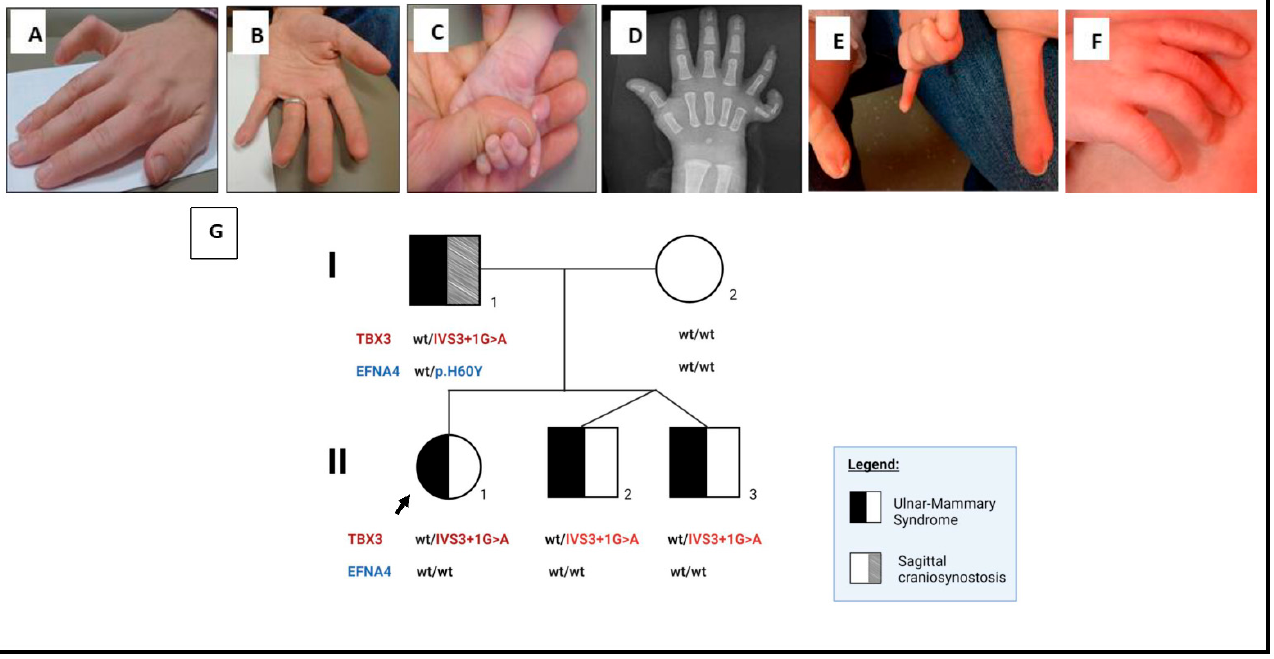
Figure 1. Phenotypic and genotypic findings in the proband and her family. ( A , B ) Clinical findings in the proband’s father showing a contracture of the fifth finger and duplication of the fifth fingernail. ( C , D ) The proband’s right hand showing the postaxial polydactyly and duplication of the fifth fingernail and the corresponding X-ray of the proband’s right hand. ( E ) Unilateral, fifth finger contracture in one of the proband’s twin brothers. ( F ) Normal hand in the other twin brother. ( G ) Pedigree of the family with the associated TBX and EFNA4 allele. The proband is indicated by the short arrowhead in black (Individual II:1). The proband and her siblings (II:2 and II:3) are heterozygous for the TBX3 variant. The proband’s father (Individual I:1) is heterozygous for both the TBX3 and EFNA4 variants. The proband’s mother (Individual 1:2) is wild-type for both alleles.